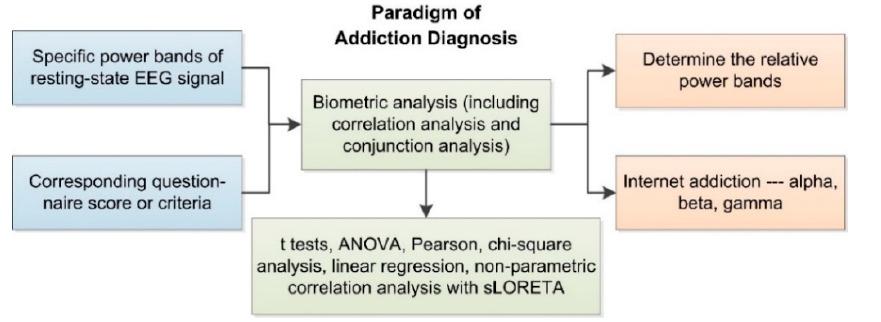
Figure 1. Biostatistical analysis paradigm of IA, corresponding questionnaire, and criteria include Young’s Internet Addiction Test (IAT) and DSM-V et al.